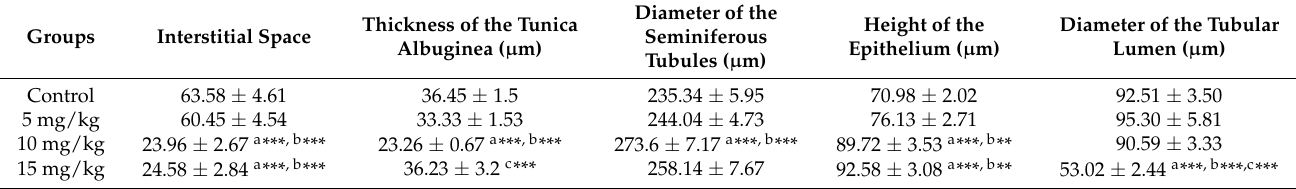
All values are expressed as mean ± SEM ( a = comparison to control, b = comparison to 5 mg/kg group, c = comparison to 10 mg/kg group.